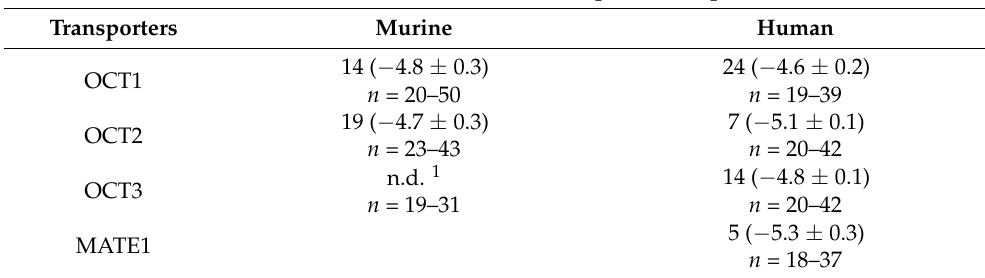
Table 1. Summary of IC 50 -values for Masitinib inhibition of ASP + transport mediated by murine and human OCT paralogs and orthologs and